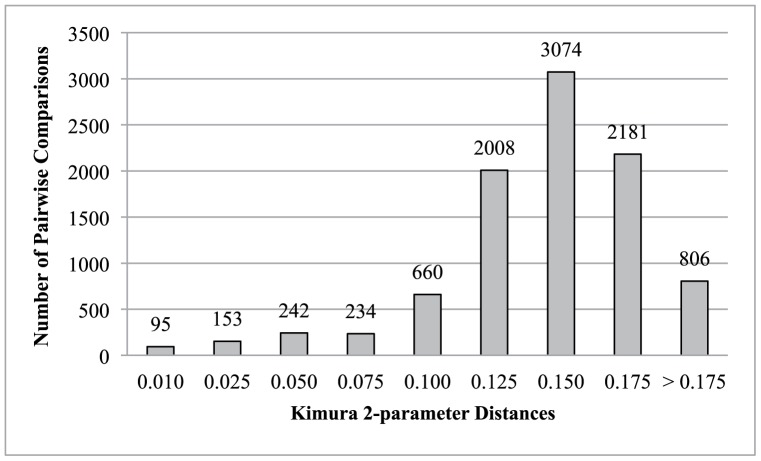
Kimura 2-parameter pairwise distances based on cytochrome-b sequence data.Y-axis indicates the number of total pairwise comparisons of sequences and the X-axis indicates the Kimura 2-paramter distance values among ingroup taxa. Note the large portion of pairwise values over 10% (average divergence of 13.14%).